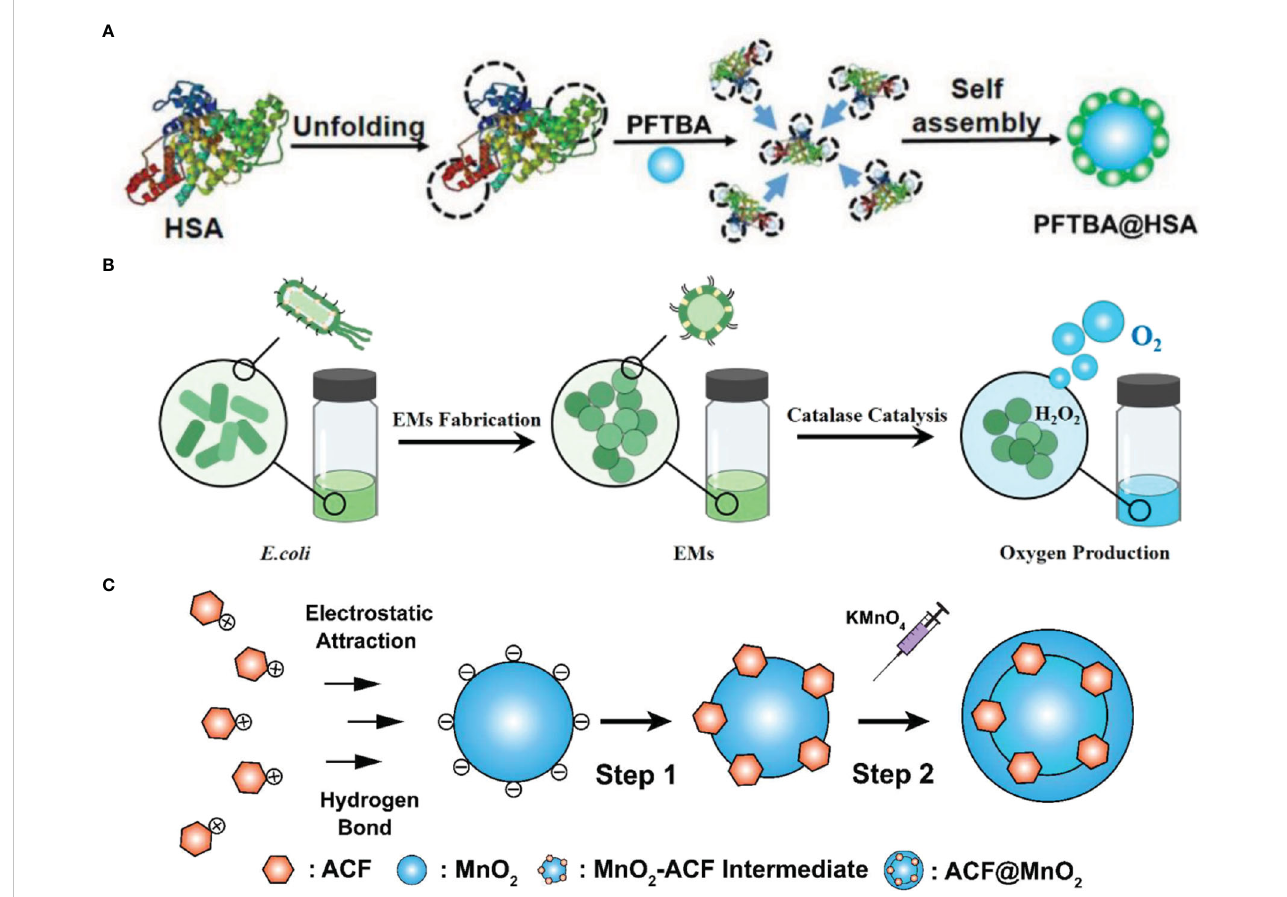
FIGURE 2 The fabrication of oxygen switches. (A) Schematic illustration of PFTBA@HSA preparation (17). Copyright © 2021, The Author(s). (B) Schematic illustration of EMs preparation (3). Copyright © 2021, American Chemical Society. (C) Schematic illustration of CAT-SAHA@PLGA preparation (23). Copyright © 2021, The